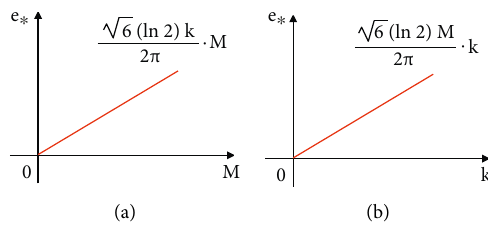
Figure 5: Optimal effort level curve (a) The relationship between optimal effort levels e ∗ and M . (b) The relationship between op- timal effort levels e ∗ and k .